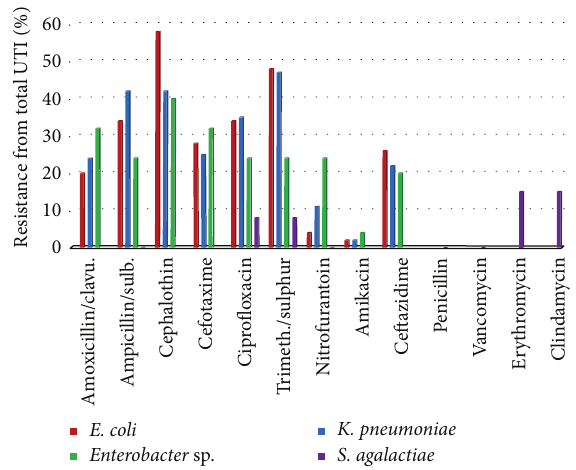
Figure 3: Resistance pattern for most UTI prevalent Gram-negative and Gram-positive pathogens in all population